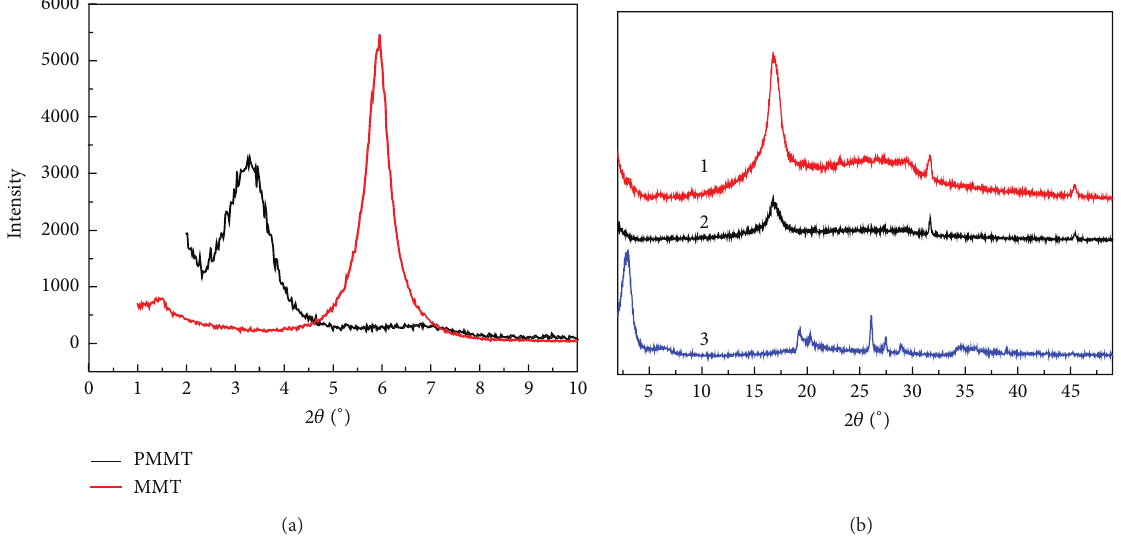
Figure 3: XRD: (a) Na-MMT and PMMT; (b) 1: the PMMT content 5wt%, 2: the PMMT content 8 wt%, and 3: